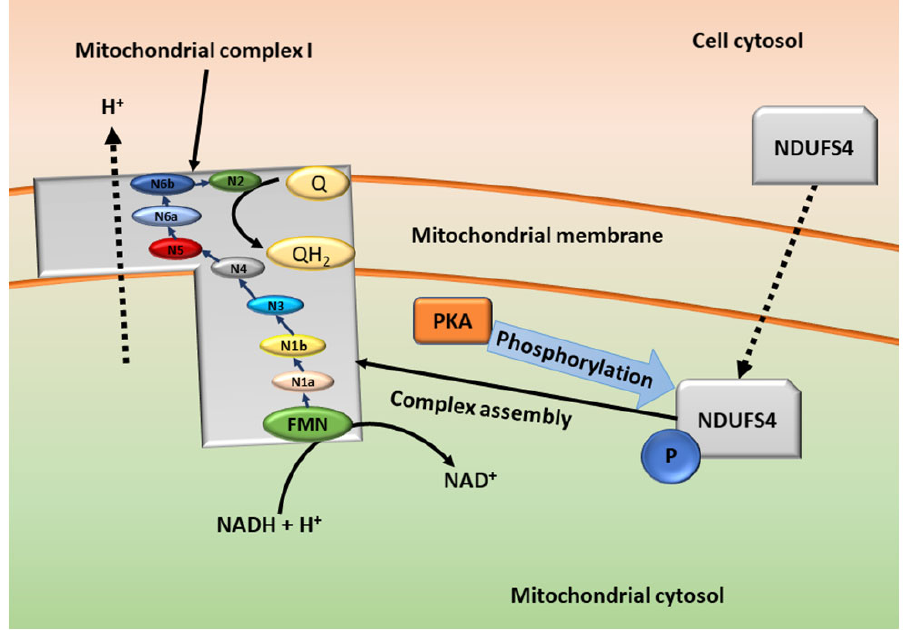
Figure 3. Schematic diagram of the formation and function of the mitochondrial complex I. NDUFS4 is synthesized in the nucleus and transported to the cell cytosol. In the cytosol, PKA can phosphorylate it before it is transported into the mitochondria (not shown) or NDUFS4 is transported into the mitochondrial cytosol where it is phosphorylated by PKA. NDUFS4 then assists in the assembly of the mitochondrial complex I. The mitochondrial complex I can then oxidize NADH to 2NAD, transferring electrons via an electron chain to Ubiquinone (Q). Flavin mononucleotide (FMN) is the entry point for electrons from NADH; electrons are then transferred to iron–sulfur clusters with several different enzymes involved. The pathway of electron transport is indicated by the blue arrows. Ubiquinone is the final electron acceptor and is then reduced by coenzyme Q (coQ) to ubiquinol (QH 2 ) [55,56]. Image created by DA Gomes using Microsoft ® office PowerPoint (Microsoft office enterprise 2007, 2006 Microsoft Corporation, United states of America).